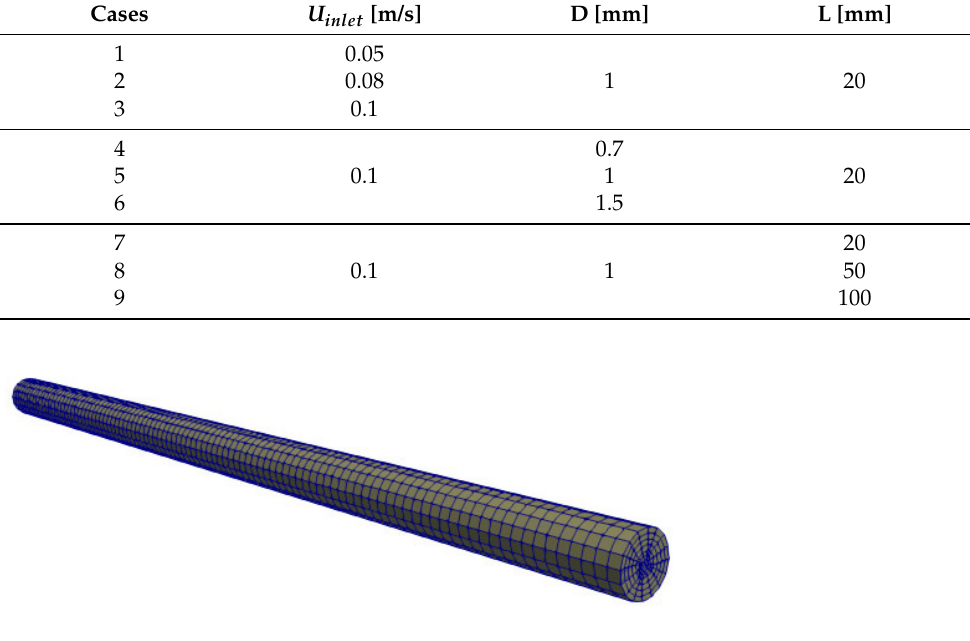
Figure 6. Filling of a straight pipe: numerical domain (case